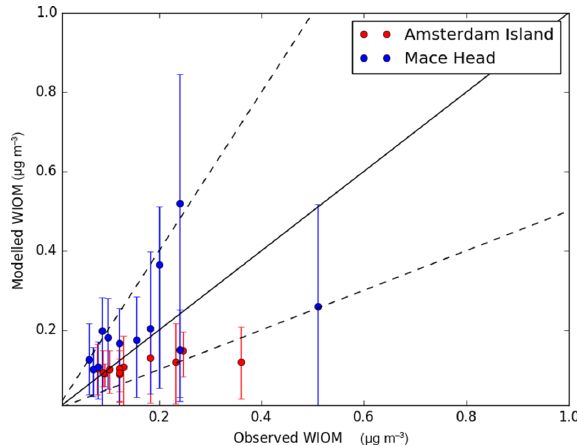
Figure 1. Evaluation of modelled water-insoluble organic matter (WIOM) mass concentration with monthly mean observations at Mace Head (53.33 ◦ N, 9.9 ◦ W) and Amsterdam Island (37.48 ◦ S, 77.34 ◦ E). The dashed lines correspond to a difference of a factor of 2 between modelled and observed values. The error bars cor- respond to the simulated daily variability within a month (maxi- mum and minimum values). Variability in the observed values is not shown because the measurements were made with filter sam- ples which were collected over 1 week, and therefore they do not represent the day-to-day variability.